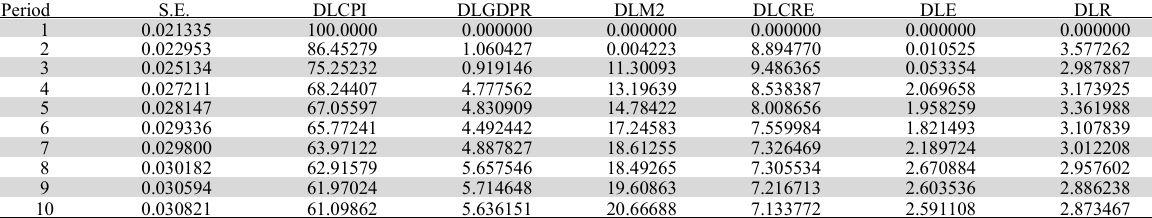
Decomposition of variance in VAR model Period S.E. DLCPI DLGDPR DLM2 DLCRE